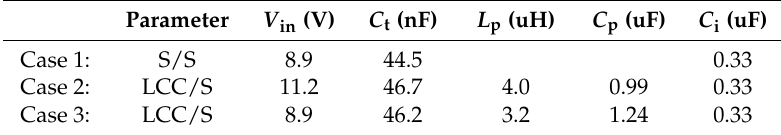
Table 2. Other parameters used in the